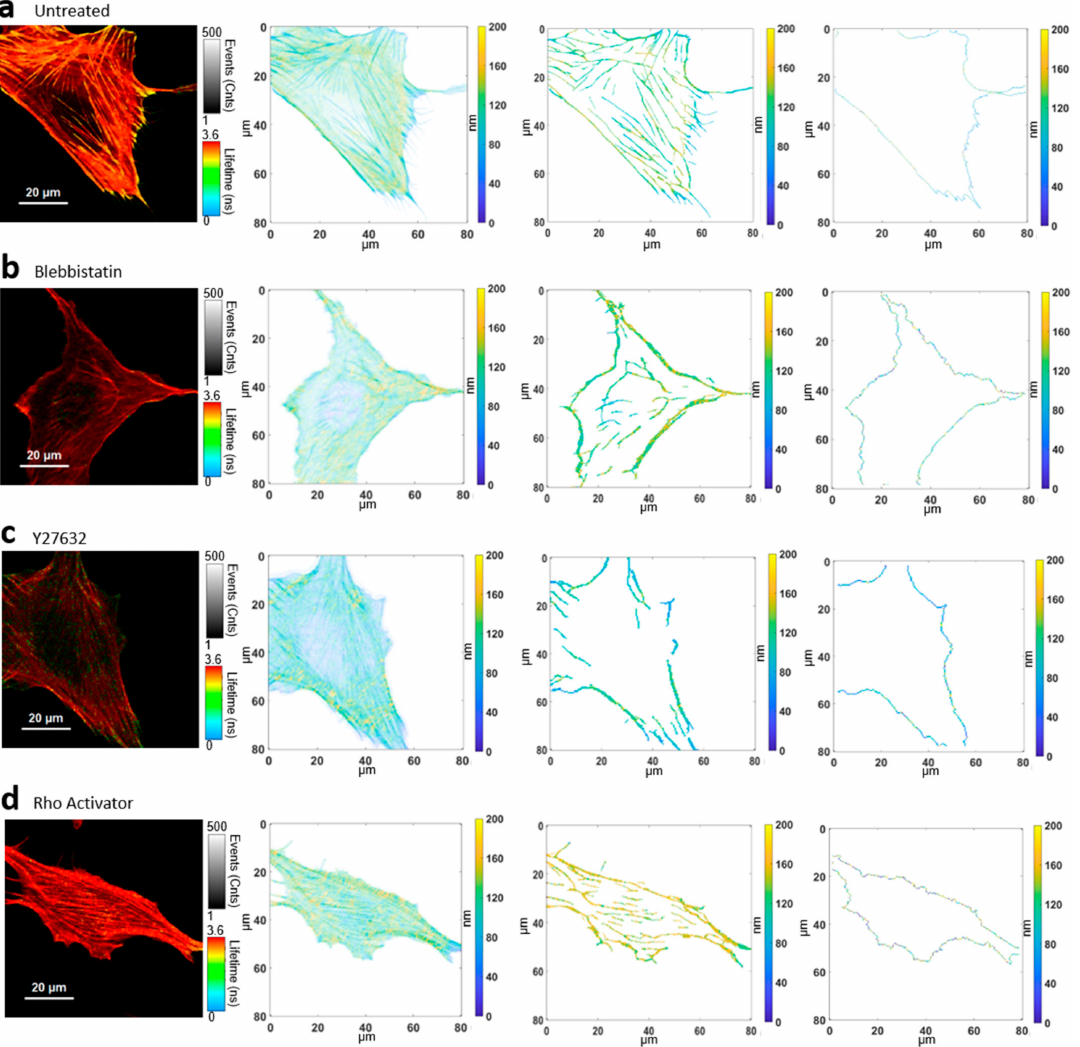
Figure 2. Converting fluorescence lifetime to height values for further analysis. ( a ) Untreated cell: FLIM image, intensity weighted height image of the actin cytoskeleton, extracted stress fiber height image, actin edge image. ( b ) Blebbistatin treated cell: FLIM image, intensity weighted height image of the actin cytoskeleton, extracted stress fiber height image, actin edge image. ( c ) Y27632 treated cell: FLIM image, intensity weighted height image of the actin cytoskeleton, extracted stress fiber height image, actin edge image. ( d ) Rho Activator treated cell: FLIM image, intensity weighted height image of the actin cytoskeleton, extracted stress fiber height image, actin edge